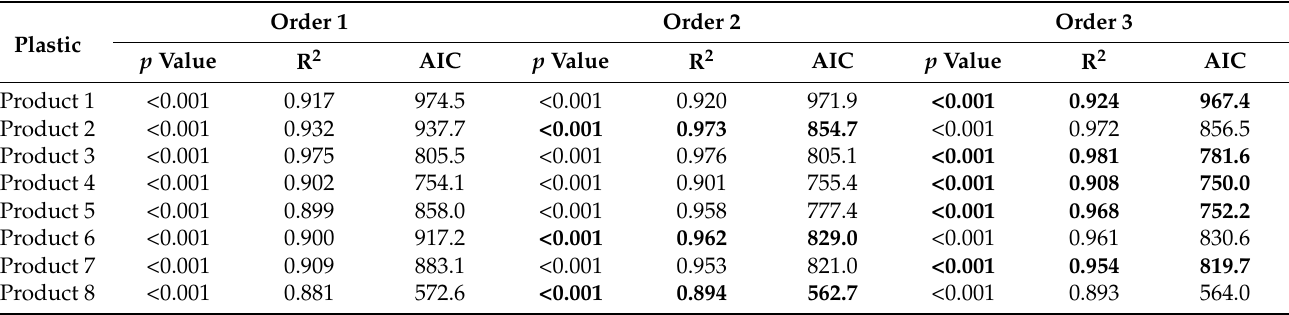
Table 6. Data of polynomial regression tests accomplished on the BMP curves. Values in bold indicate the best fitting